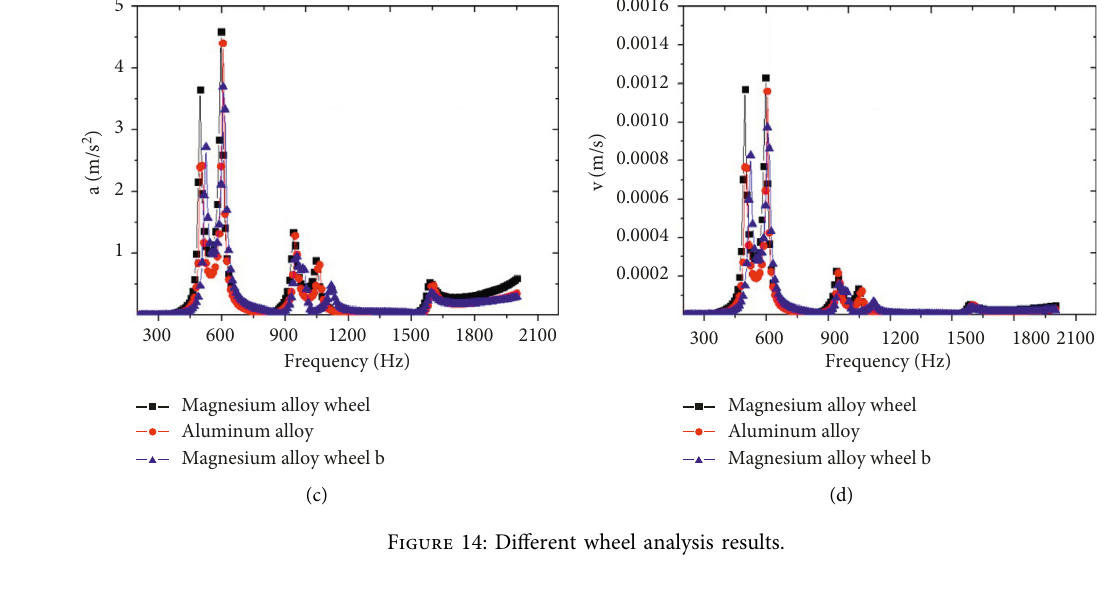
Figure 14: Different wheel analysis results.